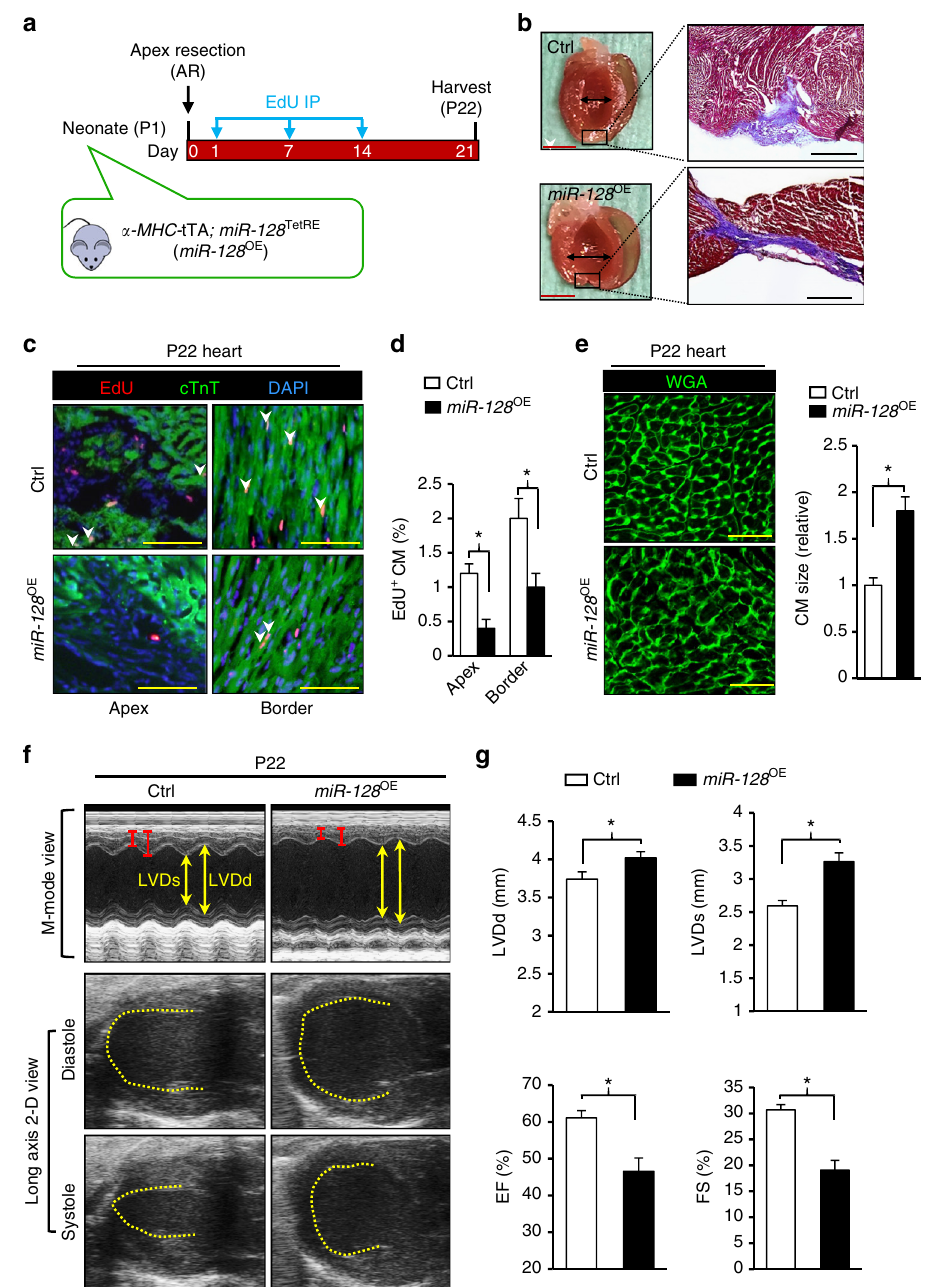
Fig. 6 Overexpression of miR-128 inhibits neonatal cardiac regeneration. a Schematic diagram depicting the timing of apex resection (AR) and EdU labeling for P1 mice. Control (Ctrl) mice were miR-128 TetRE mice, and miR-128 overexpressing mice ( miR-128 OE ) were α -MHC -tTA; miR-128 TetRE mice. b Masson trichrome staining of Ctrl and miR-128 OE hearts at day 21 after AR. Scale bars, 0.25 cm (red); 200 µ m (black). c Evaluation of CM proliferation by EdU incorporation. Scale bars, 50 µ m. d Quanti fi cation of EdU + CMs in P1 hearts at day 21 post AR ( n = 5 mice, ~250 CMs/heart). e Staining of mouse hearts with WGA at day 21 after AR ( n = 5 mice, ~200 CMs/heart). Scale bars, 25 µ m. f , g Heart function analyzed by echocardiography and quanti fi cation of LVDd, LVDs, EF, and FS ( n = 6) 21 days post AR. Statistical signi fi cance was calculated using Student ’ s t -test in d , e , and g . Data are represented as means ± SEM. * P <